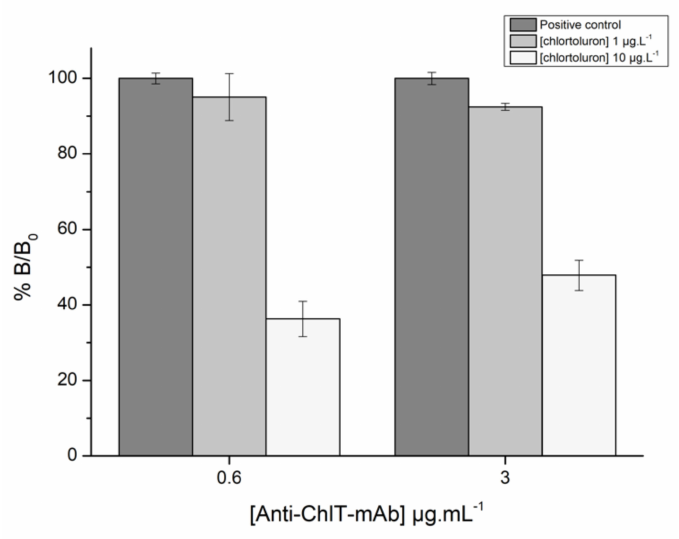
Figure 7. Relative response showing %B/B 0 obtained in the presence of antibody (Anti-ChlT-mAb) at 0.6 and 3 µ g · mL − 1 and in the presence of chlortoluron at 1 or 10 µ g · L − 1 . Streptavidin and biotinylated chlortoluron concentrations were set at 5 µ g · mL − 1